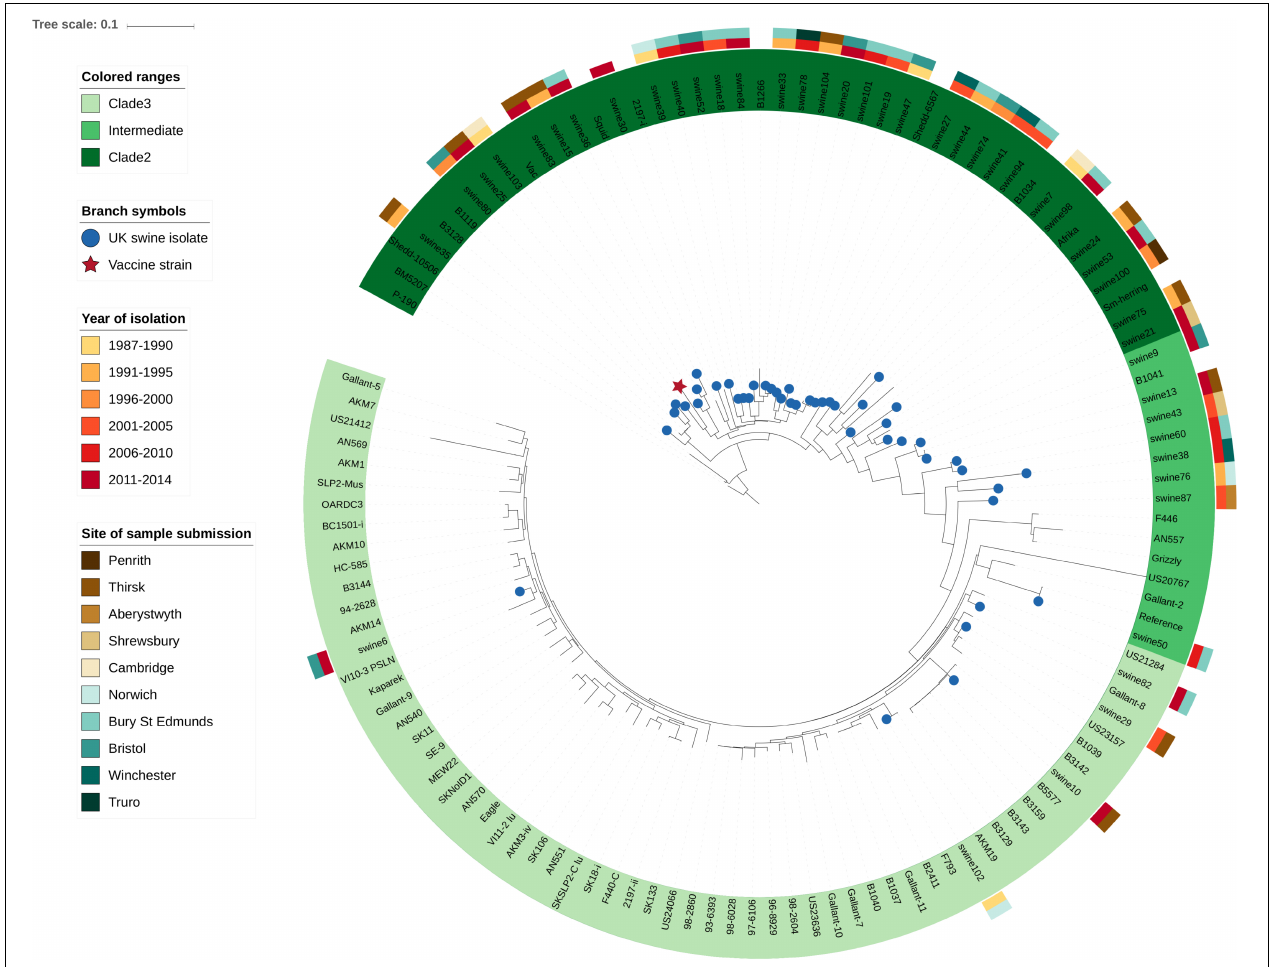
FIGURE 2 | Diversity of Erysipelothrix rhusiopathiae in British pigs as shown within a global phylogenetic context. This maximum likelihood phylogeny is based on core single nucleotide polymorphisms (SNPs) identified through the Nullarbor pipeline. British pig isolates ( n = 45) are represented by blue circles at branch tips, while the vaccine strain is represented by a red star. Branches with no symbol are isolates from a broad global collection ( n = 75) from various host species and geographic locations representing Clades 2, 3 and the intermediate clade. An isolate from Clade 1 was used to determine the appropriate rooting position (not shown). The Fujisawa strain was used as the reference genome. Spatio-temporal diversity of the British pig isolates is illustrated by color bars to the outside of the phylogeny, with the inner color representing the year range of isolation, and the outer color bar representing the veterinary center to which the isolate was